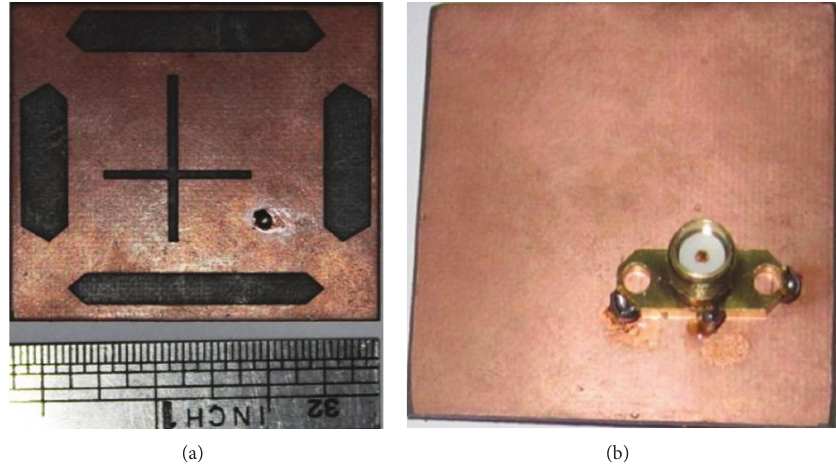
Figure 9: Prototype of the proposed antenna: (a) front view and (b) back view.